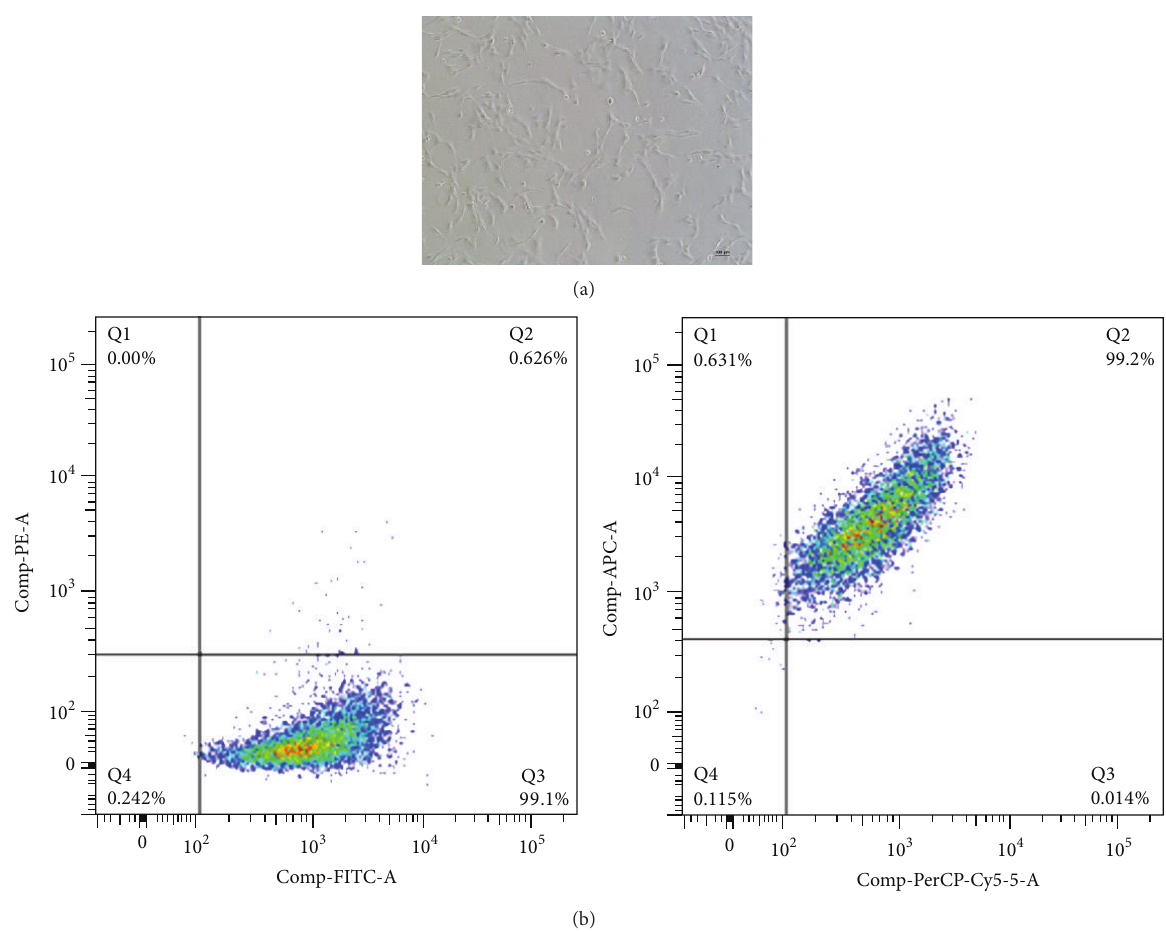
Figure 1: Phenotype identification of HUMSCs using flow cytometry. (a) Morphology of HUMSCs. Scale bar = 100 𝜇 m. (b) There are 98.3% of HUMSCs, positive for CD90 FITC/CD105 PerCP-Cy5.5/CD73 APC but negative for CD34, CD45, CD11b or CD14, CD19 or CD79 𝛼 , and